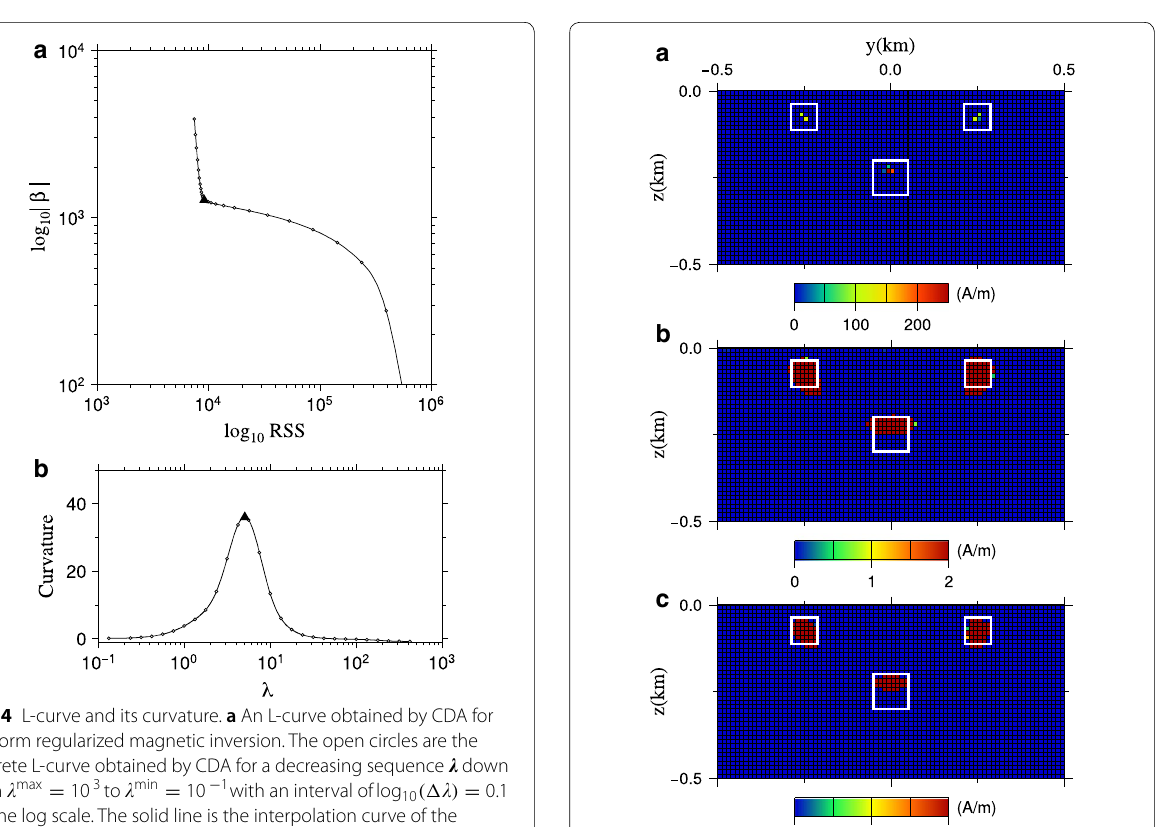
0.1 = Fig. 5 Cross-sections of the synthetic model. Cross-section through 0km profile of the models derived by L1 norm regularization the x = with a no bound constraint, with bound constraint of b β β 4 . White squares indicate the location of the magnetized blocks ≤ of the true